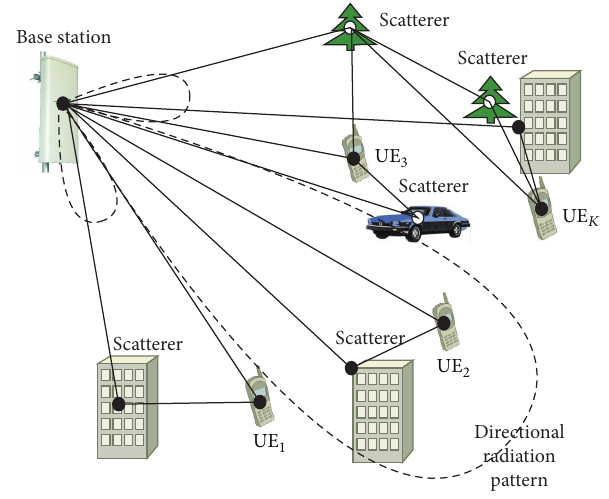
Figure 1: An example of the propagation